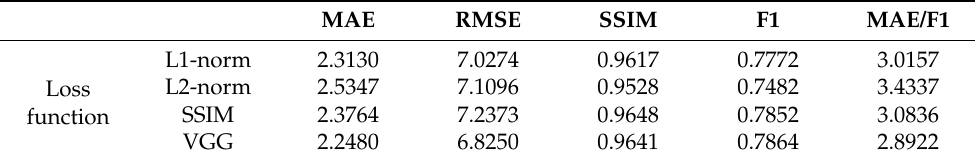
Table 4. Statistical comparisons according to loss